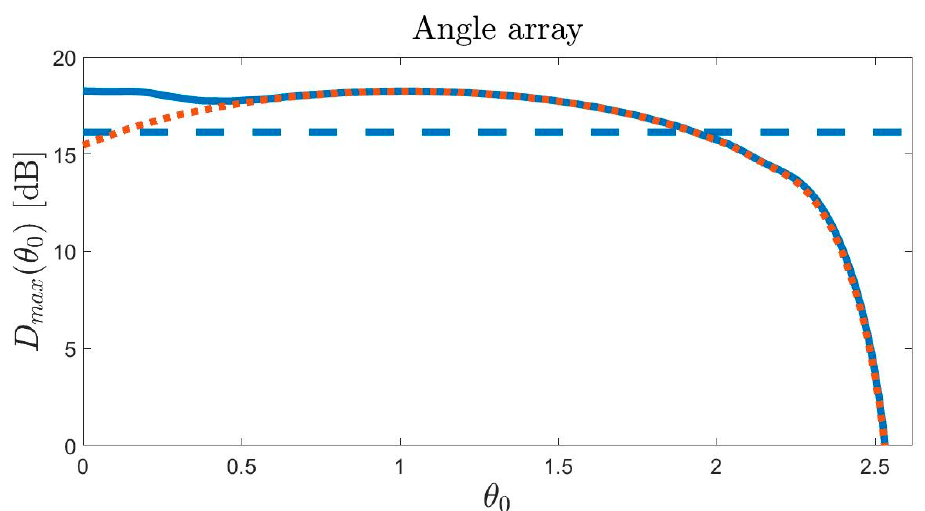
Figure 7. The behavior of the maximum directivity D max ( θ 0 ) of the angle array (solid blue line) in Figure 4 and its the corresponding value of D max (dashed blue line). The dotted red line represents the maximum directivity D max ( θ 0 ) due to the only upper linear array forming the source, which specularly acts with respect to the lower array. The dashed red line is the corresponding value of D max . Table 1. Table of the values of the parameters used to compare the arrays. Array